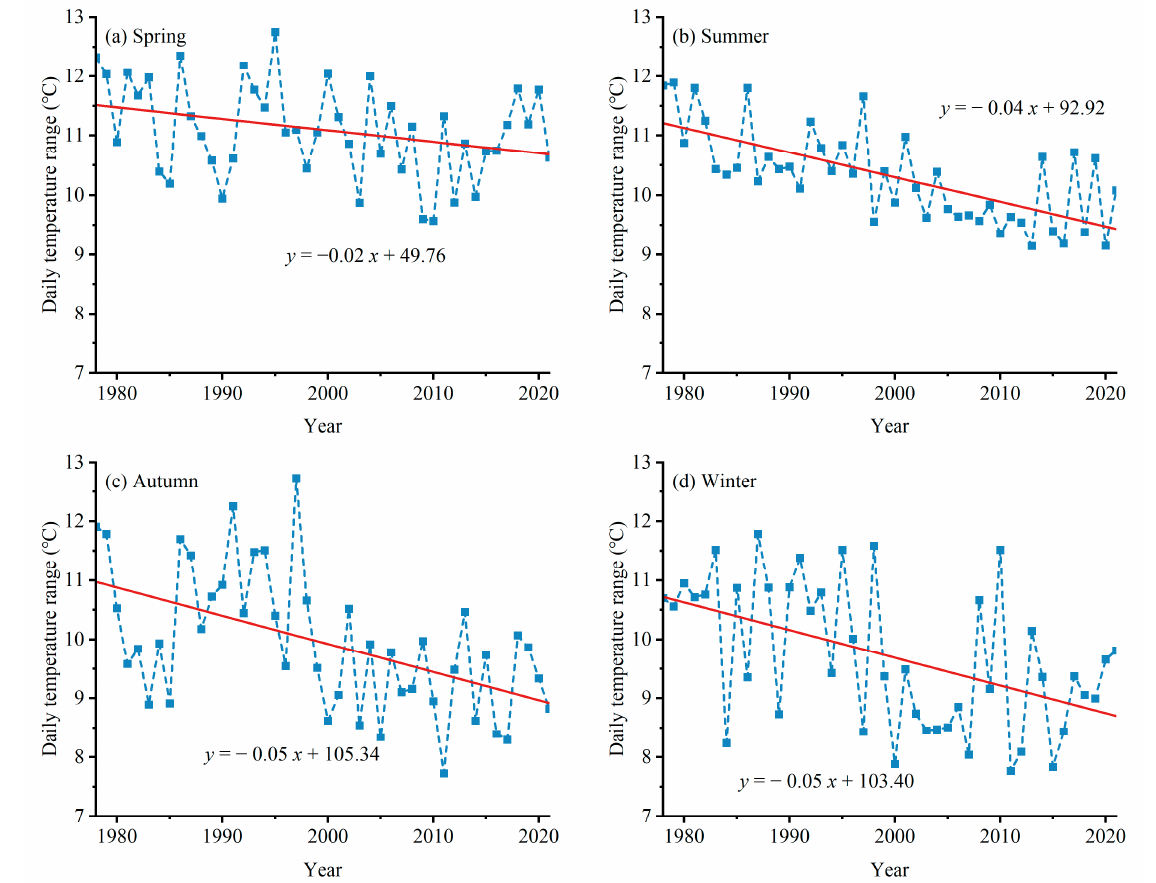
Figure 6. Variation trends of the daily temperature range in Henan Province from 1978–2021 under seasonal scale. ( a – d ) represent the seasonal scale, where ( a ) represents spring, ( b ) represents summer, ( c ) represents autumn, and ( d ) represents winter.